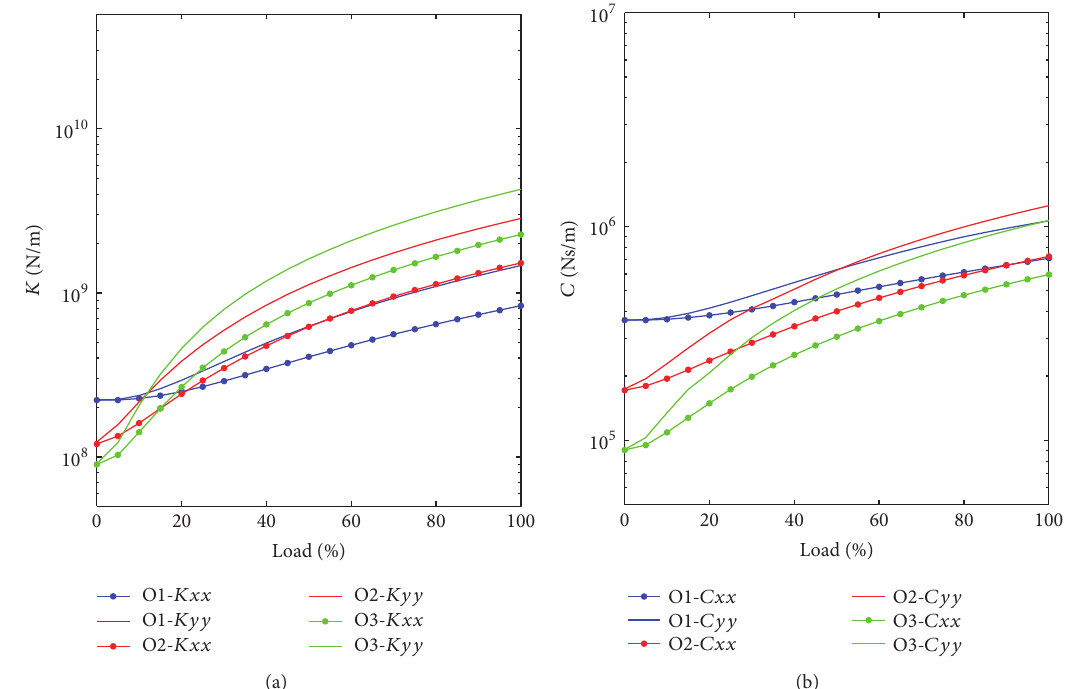
Figure 9: Effect of increasing workload on the tilting pad bearings of three output shafts, (a) stiffness coefficients; (b) damping coefficients. where 𝑇 is the torque; 𝑃 is the workload; 𝑛 is the rated